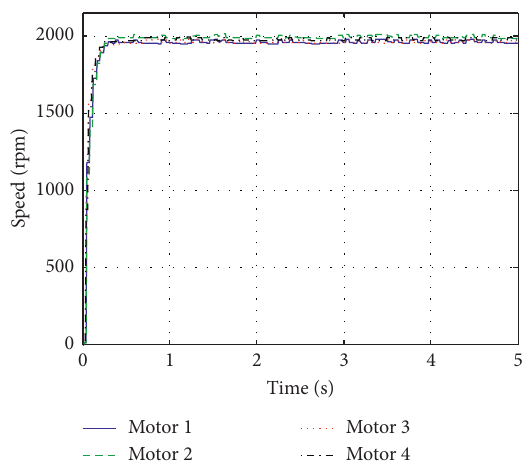
Figure 14: Synchronous output after fault